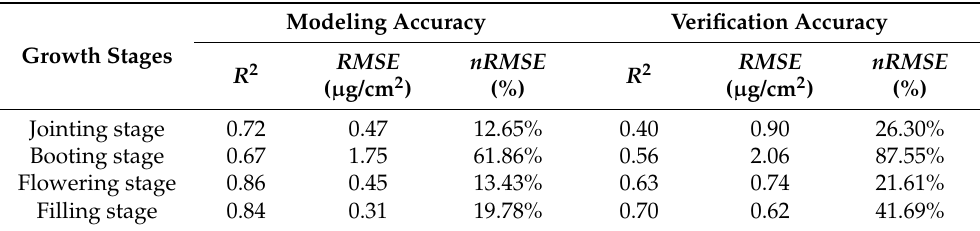
Table 1. Optimal subset regression modeling results of LAI estimation based on fractional differenti- ation spectrum at different growth stages.